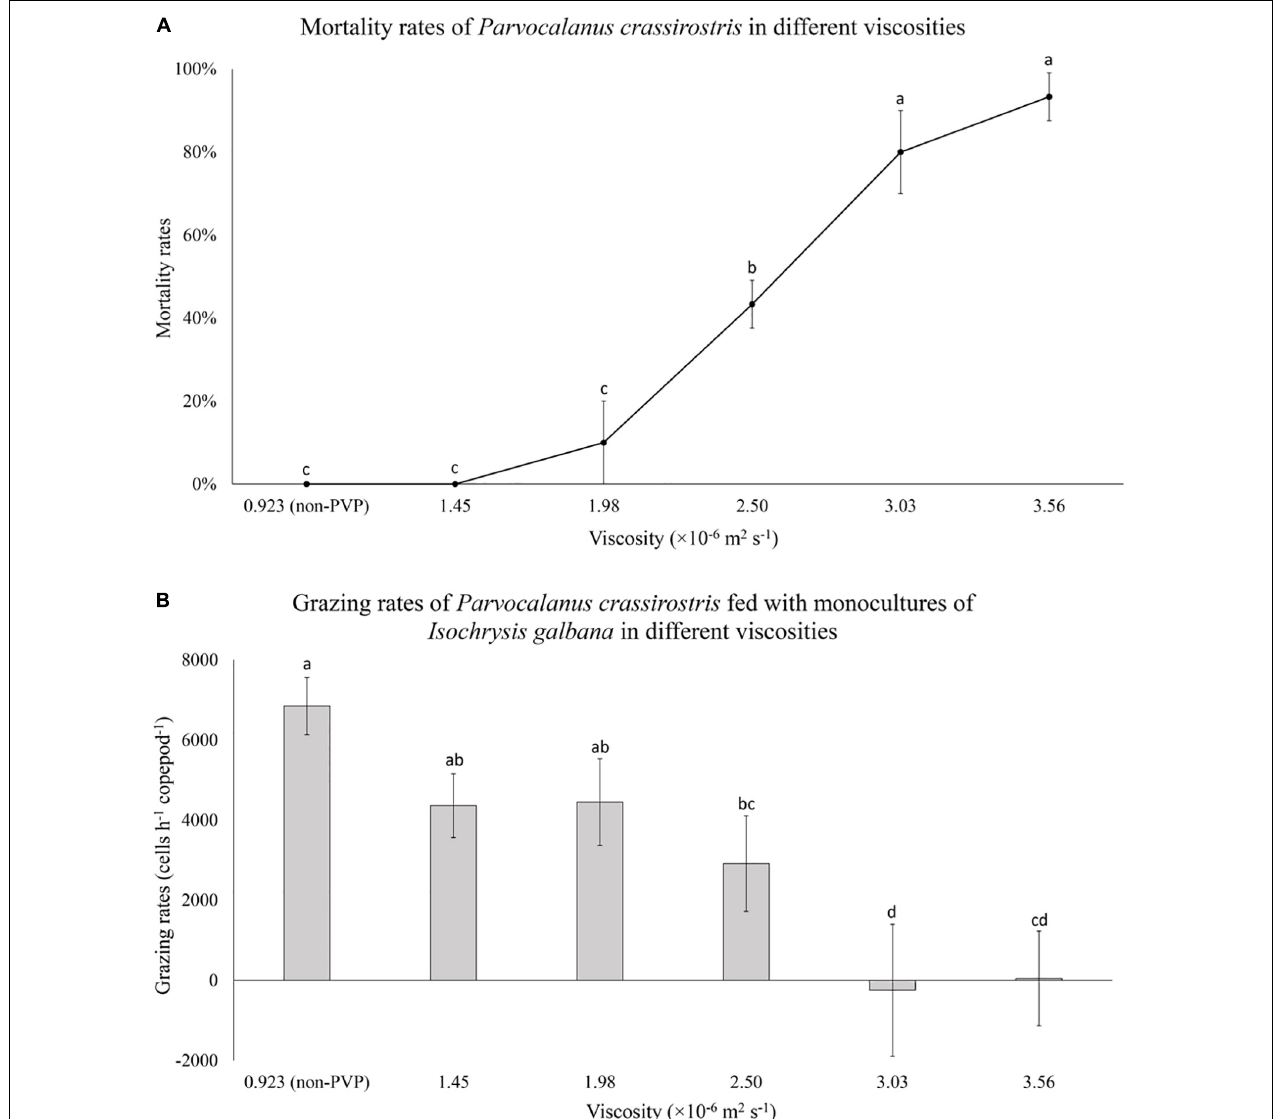
FIGURE 3 | (A) Mean mortality rates ( ± standard deviation, SD) for Parvocalanus crassirostris exposed to water with different viscosities and (B) mean numbers of cells consumed per hour ( ± standard deviation, SD) by P . crassirostris grazing on 1.8 × 10 4 cells ml − 1 of Isochrysis galban a in water with different viscosities. Different letters identify significantly different means based on analysis of variance and Tukey’s post hoc pairwise comparisons ( α = 0.05). Non-PVP, unaltered algal